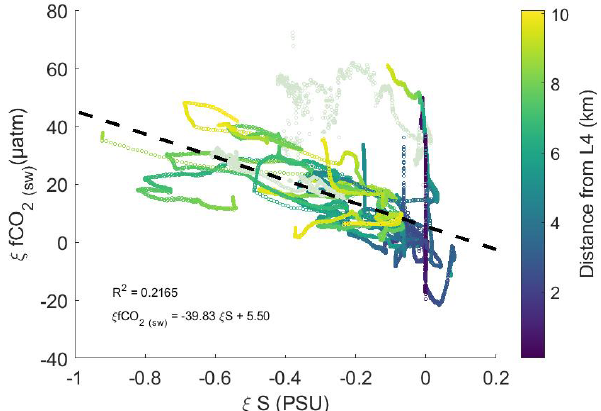
Figure 8. Scatter plot of ξS versus ξ f CO 2 ; difference of data from transects between Plymouth Breakwater and station L4 between 10 June and 21 September 2016. Data are coloured by their dis- tance from station L4; the dashed black line is the best fit for the data. The data for 7 July are shown in light